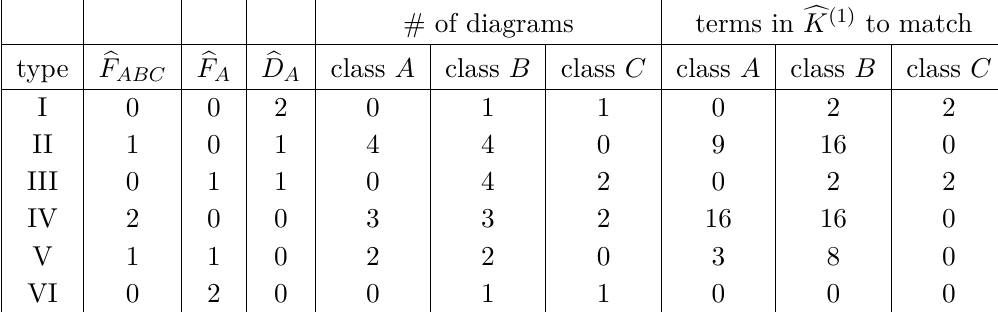
Table 1 . Different combinations of the three tensors b F ABC , b F A , and b D A with the number of different possible diagrams obtained by combining two of them. We reference each combination with a Roman numeral from I to VI and further specify one of three classes, A , B , or C